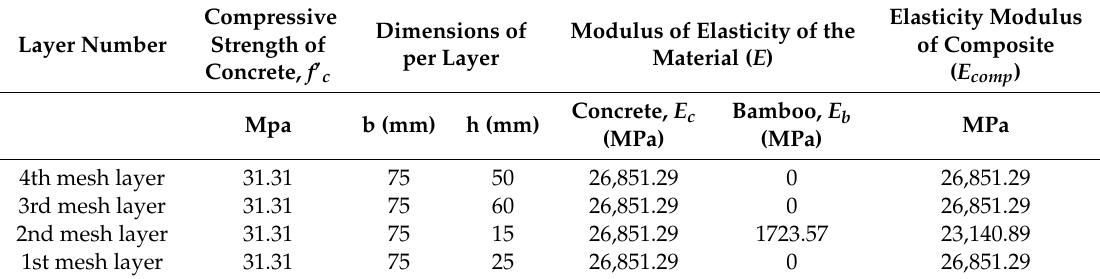
Table 3. Elasticity Modulus of Composite of BRC beam.